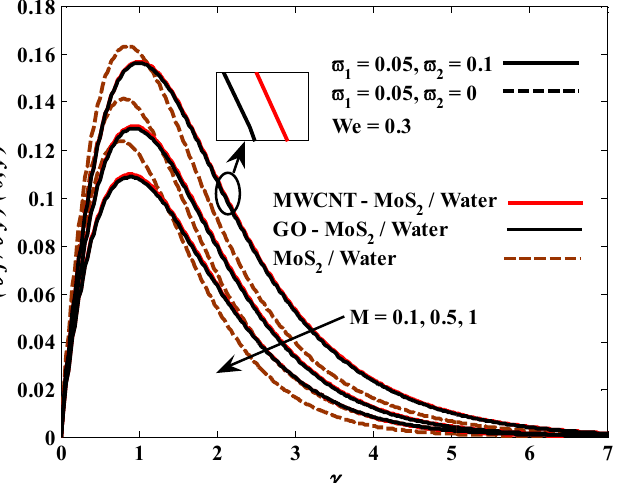
Figure 12. The behavior of hybrid nanofluid’s velocity under the effect of M.